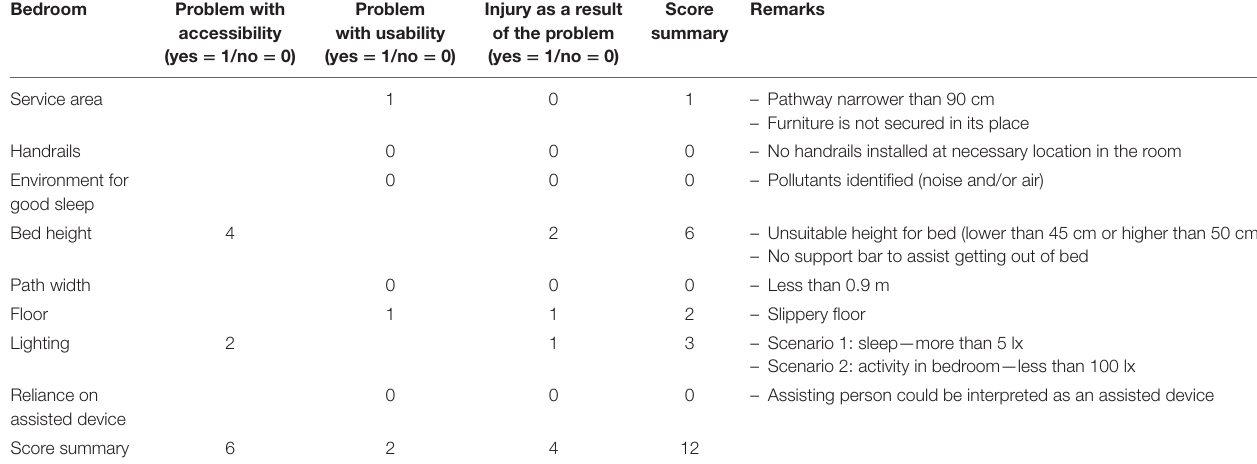
TaBle 3 | Summary score for bedroom assessment in five Parkinson’s disease patients.